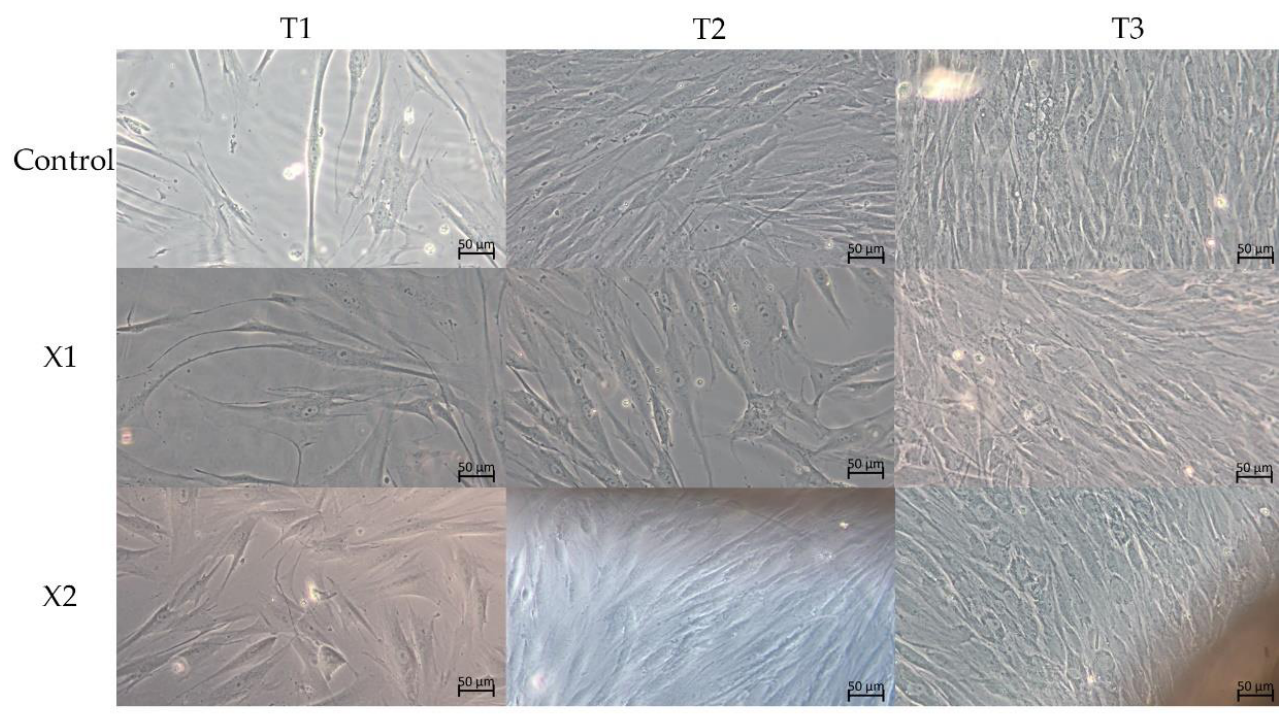
Figure 2. Contrast-phase light microscopy images of HPLF cells with the examined materials and controls at the different examined times. 20× magnification.